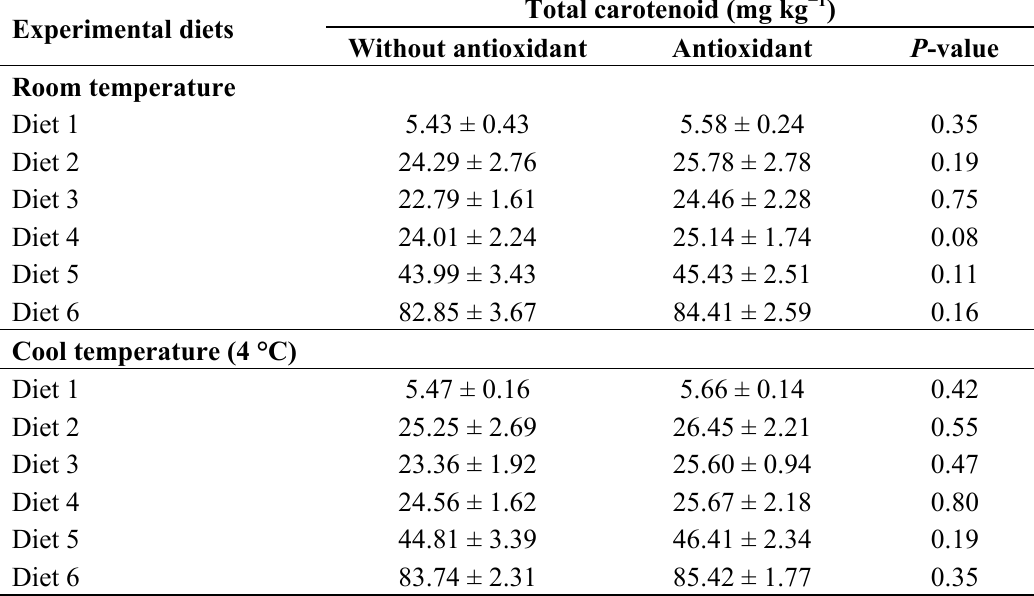
Table 5. Comparing total carotenoids content in the experimental diets with and without antioxidant at 26–28 °C and 4 °C during 8